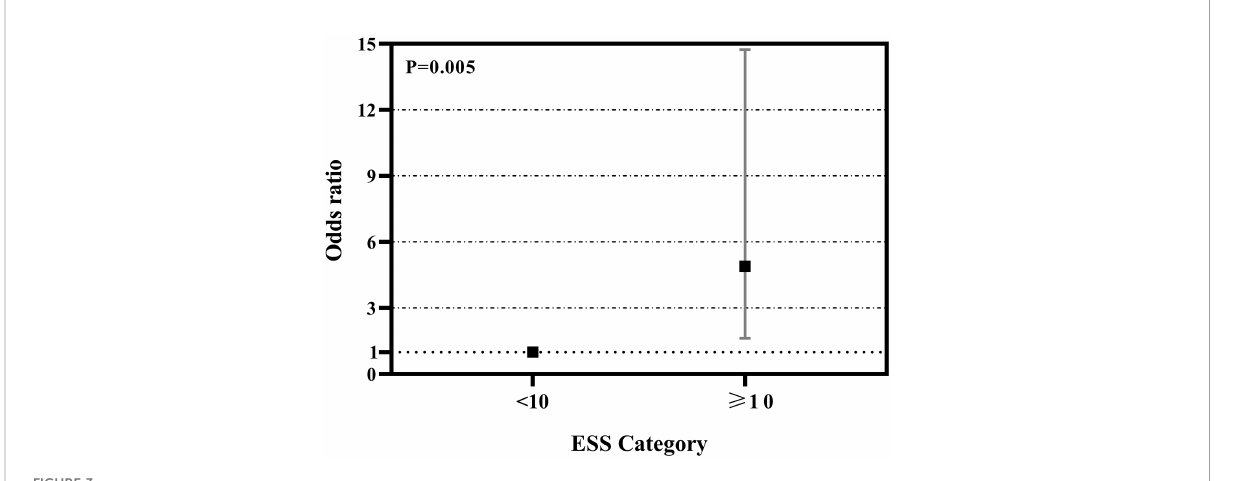
FIGURE 3 Odds ratios (OR) and 95% con fi dence interval (CI) of hypothyroidism by ESS category in men patients with OSA. † Adjusted for age, BMI, smoking, drinking, and family history of